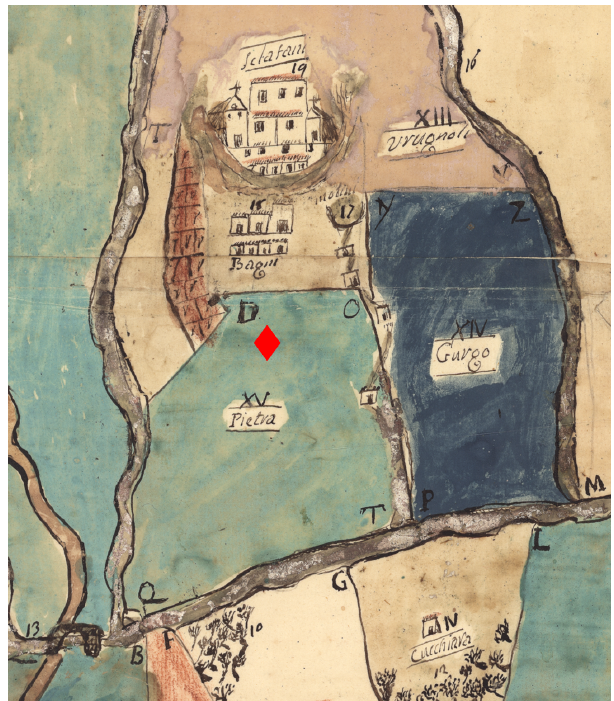
Figure 6. Map of the fiefs and territory of Sclafani (detail) drawn by Gaetano Salemi (India ink and watercolour, 1833; not oriented). The detail shows the small town, the prominent spur (brick floor in the map) at the base (Lower Cliff) of Mt Sclafani, the “thermal bath houses” ( Bagni ), the thermal pond (number 17) and Ferran- dina’s water mills ( Molini ). State Archive of Palermo, section of Gancia; authorization for reproduction no. 7/2016, ref. no. 5236 – 22 November 2016. The rhombus shows the location of a new one-floor thermal establishment (1856–1857, the so-called Masse- ria Bagni i.e. “thermal bath